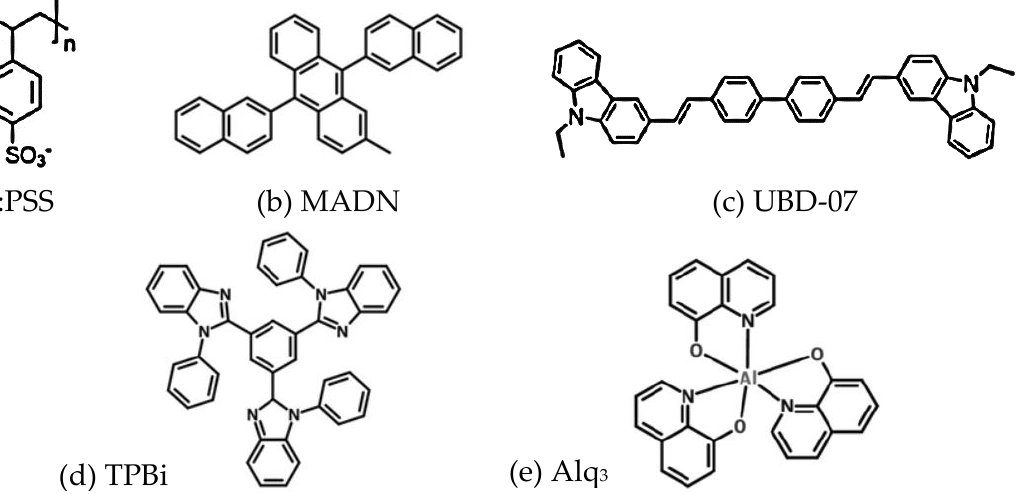
Figure 1. The molecular structures of materials used in this work.